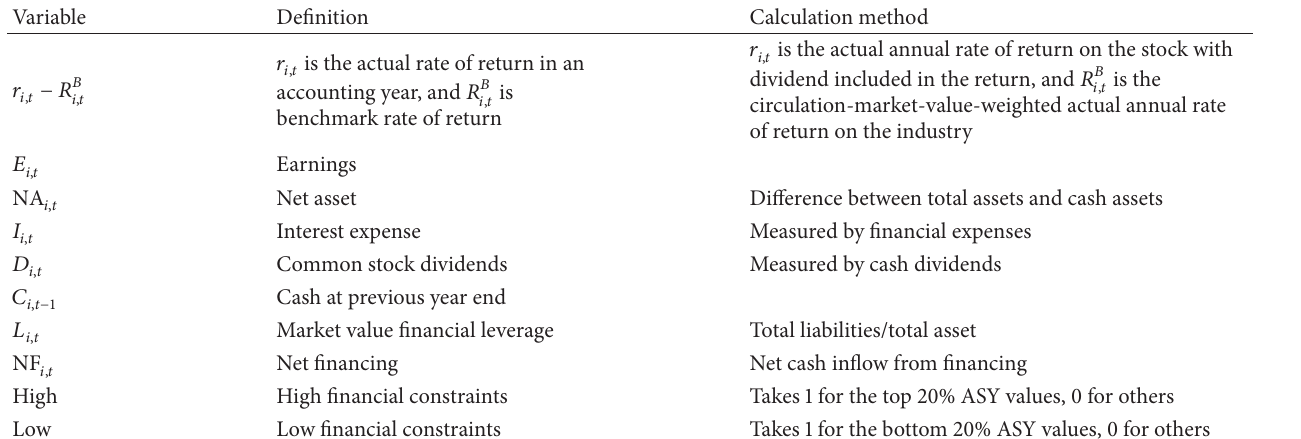
Table 2: Definitions of research